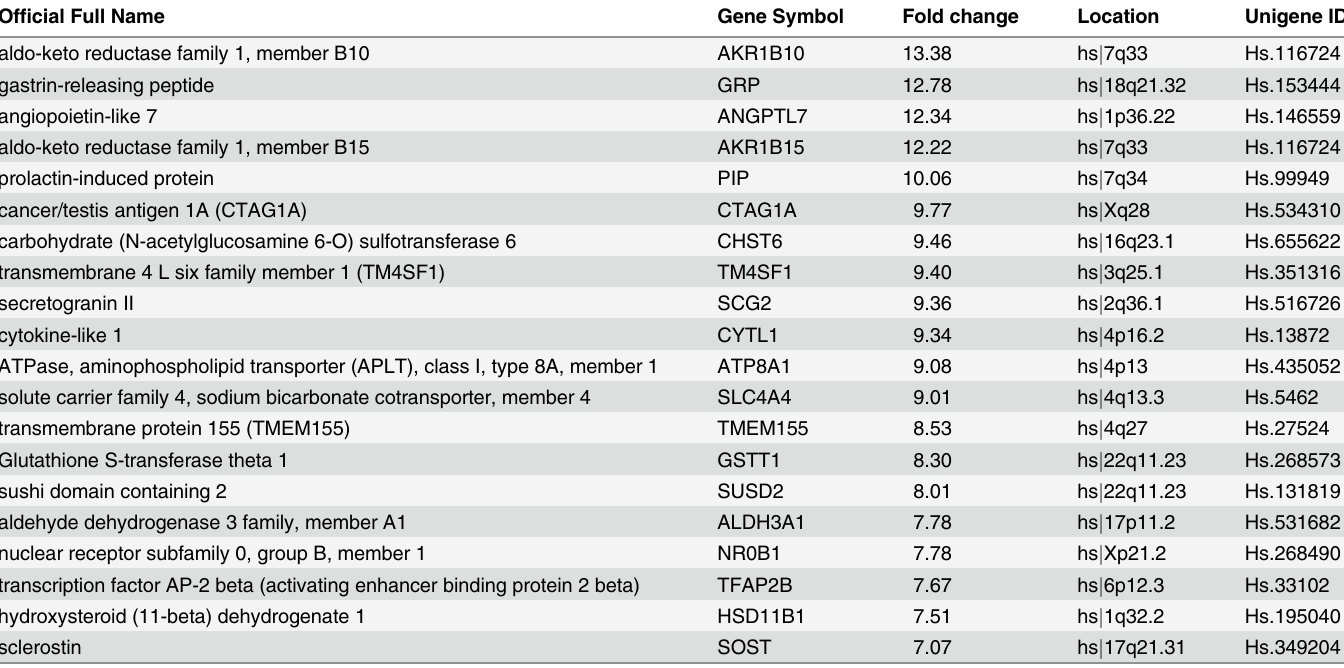
To investigate the difference between the tube-formation responses in the two co-culture mod- els, we performed microarray analysis. Table 2 shows the genes that were most upregulated in HCKs relative to those in HDFs; the Supplemental Data section lists 100 upregulated and downregulated genes in HCKs. We performed qRT-PCR to confirm the differential expression Table 2. Upregulated genes in HCKs relative to those in the